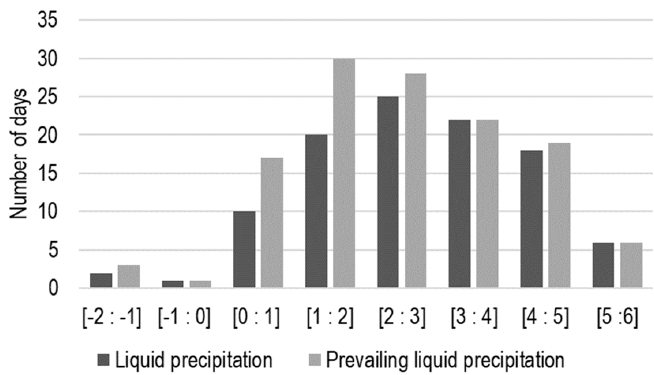
Figure 5. Frequency of winter rain (calculated from days with liquid and prevailing liquid precipitation) in air temperature intervals between 2009/2010 and 2016/2017; right-handed closed intervals.